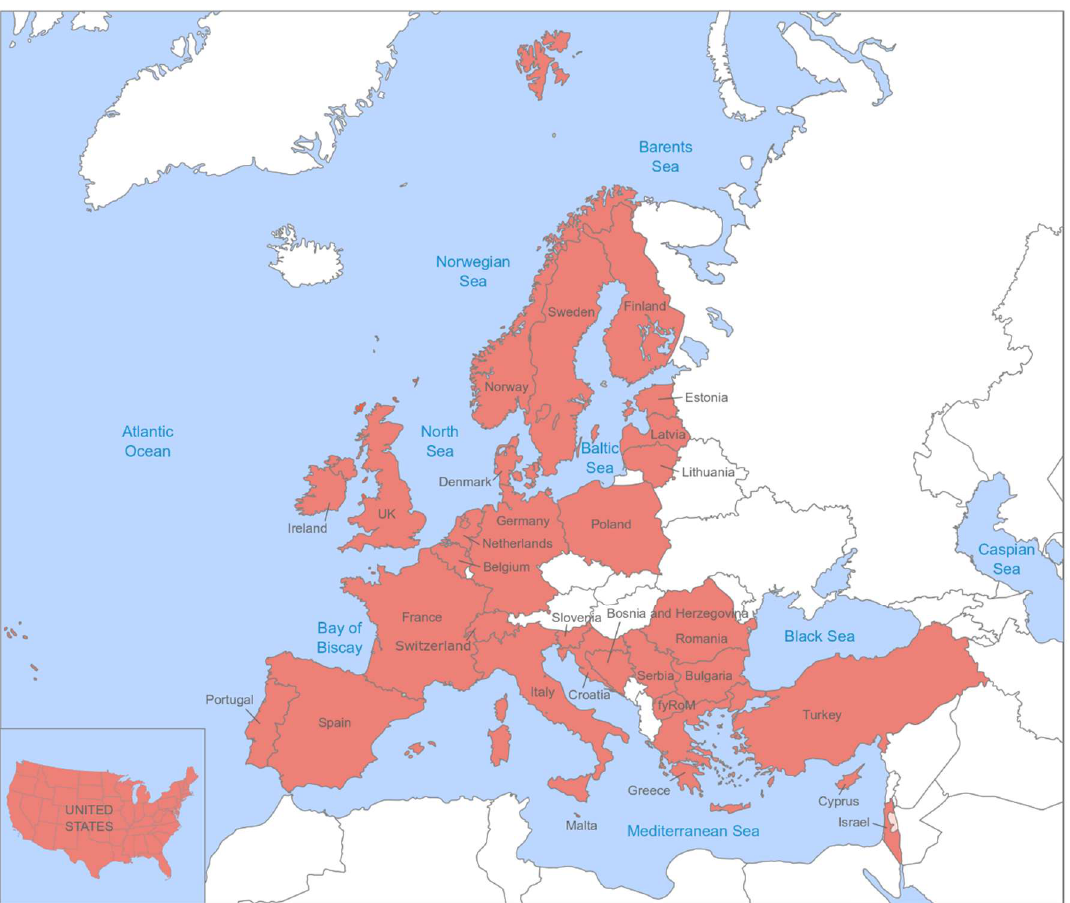
Figure 1. The WECANet COST Action represents 31 countries (in colour), which border open high-energetic oceans, and / or smaller low(er)-energetic seas. The involvement of the WECANet countries is detailed in Section 6 “Network as a whole”. Exploitation of the available wave energy potential in Europe requires a tailored approach, which is the target of this WECANet COST Action.